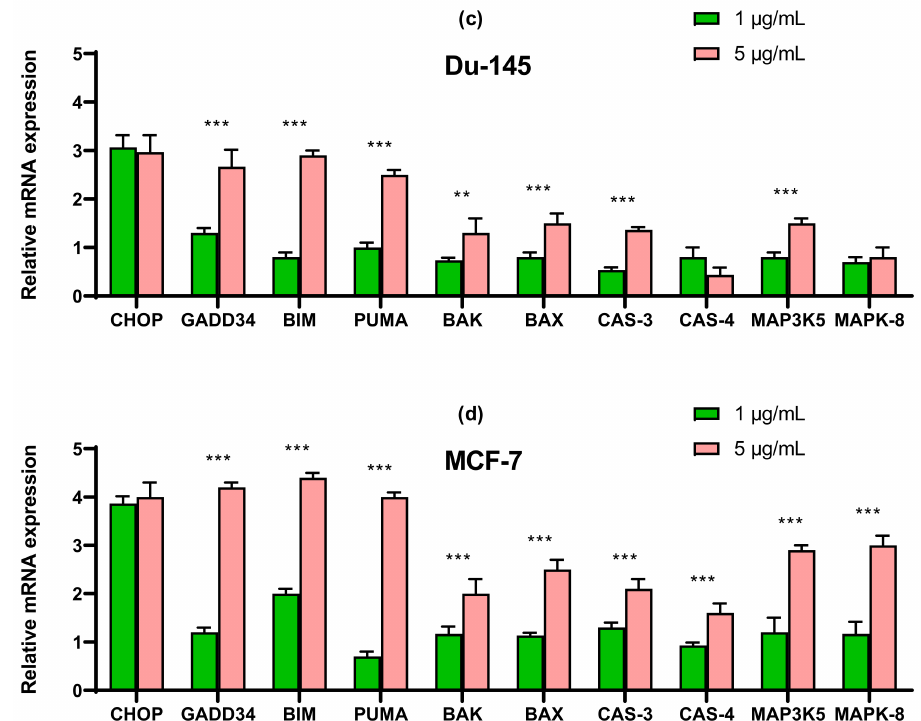
Figure 4. qRT-PCR analysis of the expression of ER stress response in gene (1 and 5 µ g/mL SeNP, 24 h)-treated cancer cells ( a )—A-172; ( b )—Caco-2; ( c )—Du-145; ( d )—MCF-7. Each value is the mean ± SD of at least three independent experiments ( n ≥ 3, p < 0.05). GAPDH was used as an internal control for normalization. Two-way ANOVA with Sidak’s multiple comparisons test. Comparison 1 µ g/mL and 5 µ g/mL, *** p -level < 0.001, ** p -level < 0.01, * p -level < 0.05.